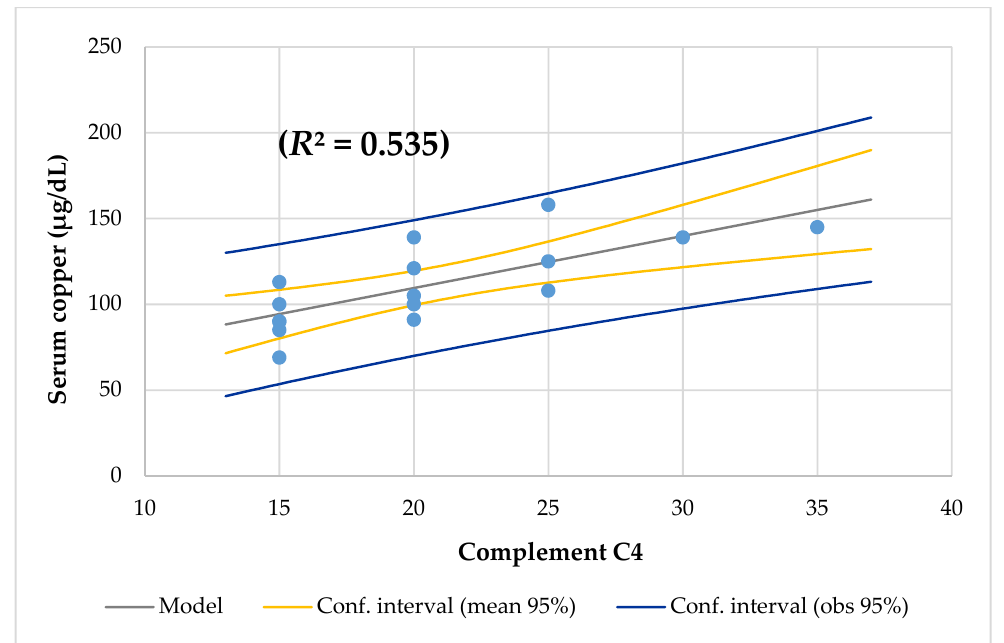
Figure 5. Regression serum copper by complement C4.